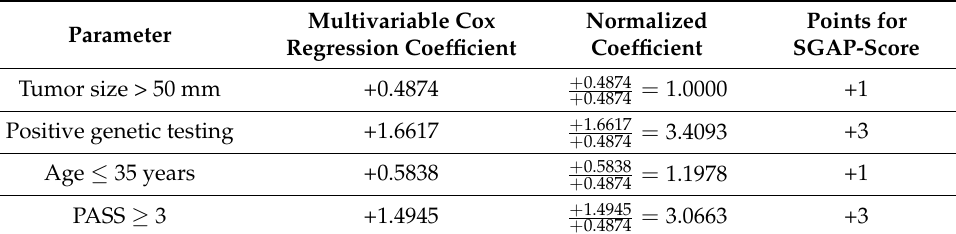
Table 1. SGAP-score point assignment according to multivariable regression coefficients. Abbrevia- tions: PASS, Pheochromocytoma of the Adrenal gland Scaled Score; SGAP, Size–Genetic–Age–PASS.